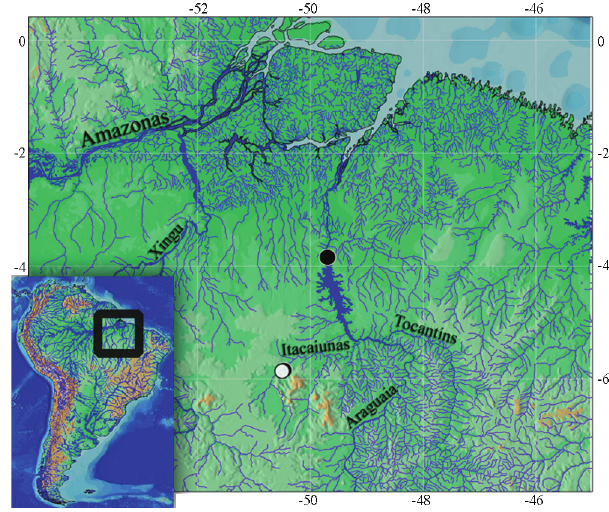
Fig. 3. Distribution of Leporinus santosi . White symbol represents the type